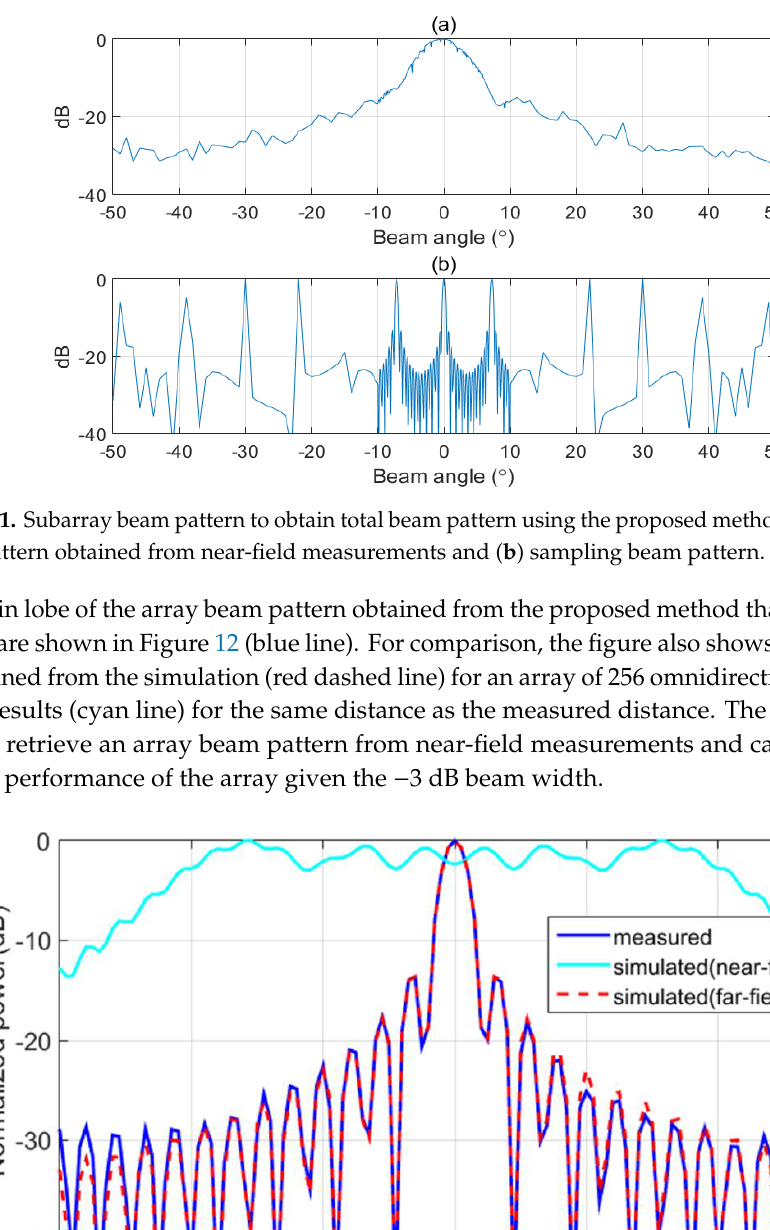
Figure 12. Beam patterns obtained from simulation and the proposed method